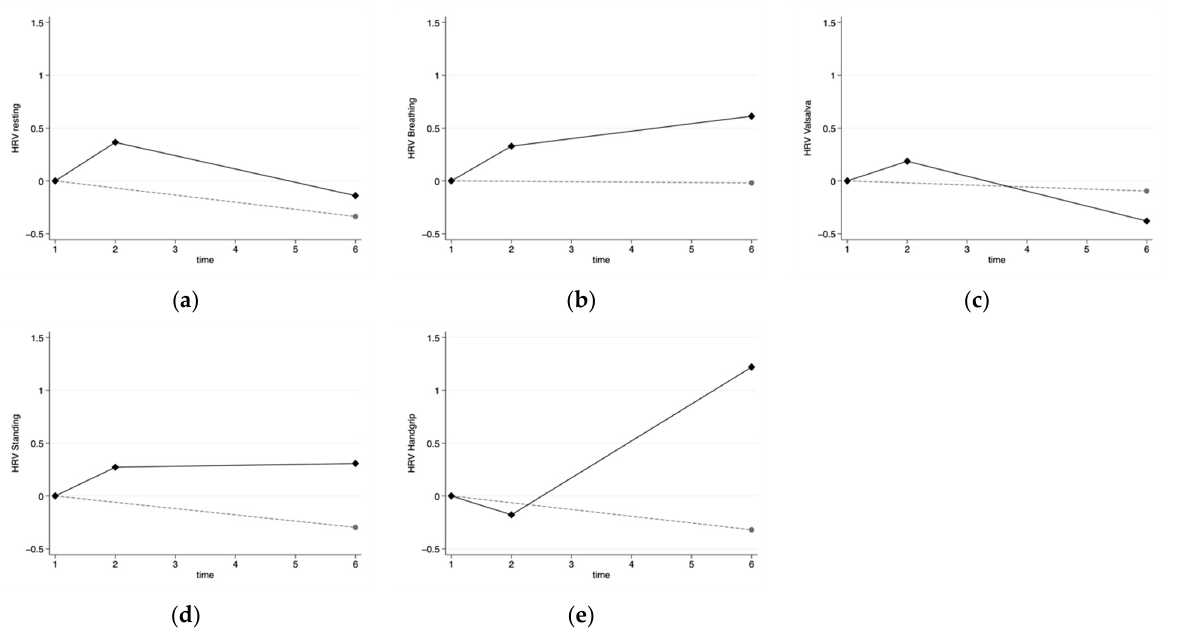
Figure 1. Progression of the heart-rate variability parameters throughout the weeks in both the control (dotted gray line) and infection (solid black line) groups: ( a ) HRV resting; ( b ) HRV breathing; ( c ) HRV Valsalva maneuver; ( d ) HRV standing; and ( e ) HRV sustained handgrip.